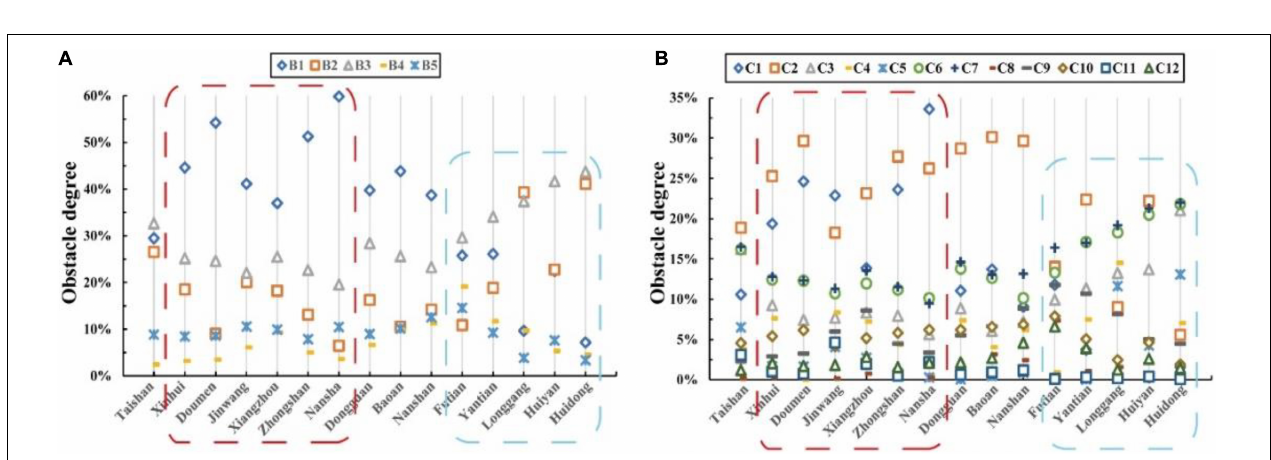
FIGURE 5 | Bar chart showing the changes in exposure, sensitivity, adaptation and erosion vulnerability in the overall coastal zone system in the study area over time.